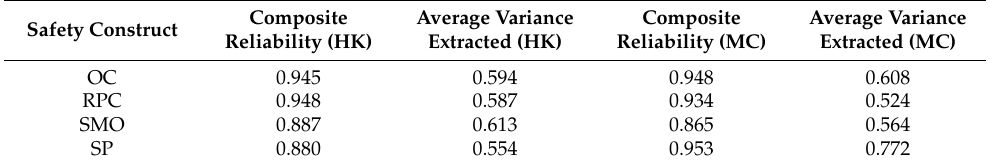
Table 4. Results of AVE and composite reliability for data.